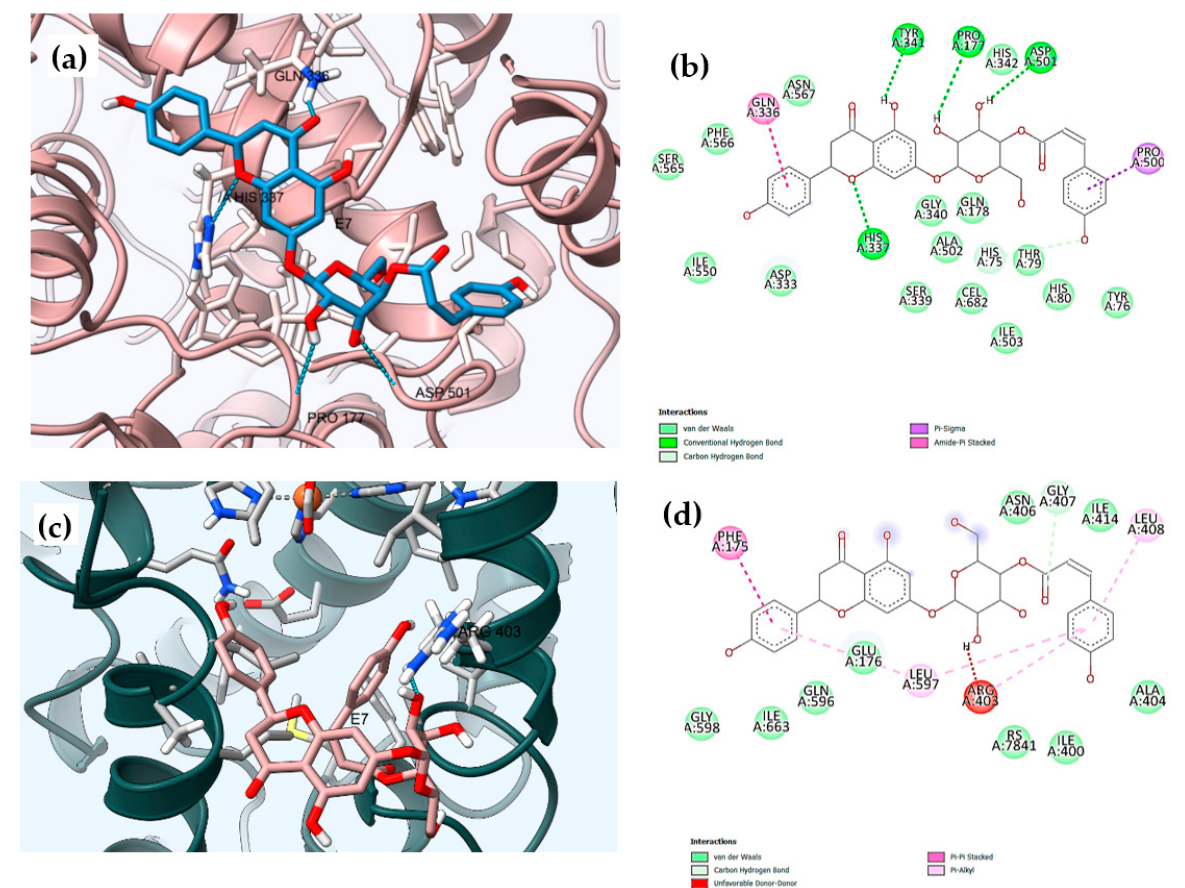
Figure 5. Three ‐ dimensional (3D) and two ‐ dimensional (2D) molecular binding interactions of the Figure 5. Three-dimensional (3D) and two-dimensional (2D) molecular binding interactions of the dual inhibitor compound E7 with: ( a , b ) cyclooxygenase ‐ 2, COX ‐ 2 (PDB: ID 3LN1), (Dimensions dual inhibitor compound E7 with: ( a , b ) cyclooxygenase-2, COX-2 (PDB: ID 3LN1), (Dimensions X:25.000, Y:21.2305, Z:24.7079); and ( c , d ) 15 ‐ lipooxygense, 15 ‐ LOX (PDB ID: 1LOX), (dimensions X:25.000, Y:21.2305, Z:24.7079); and ( c , d ) 15-lipooxygense, 15-LOX (PDB ID: 1LOX), (dimensions X:20.6138, Y: 18.9027, Z:26.9761). X:20.6138, Y: 18.9027,